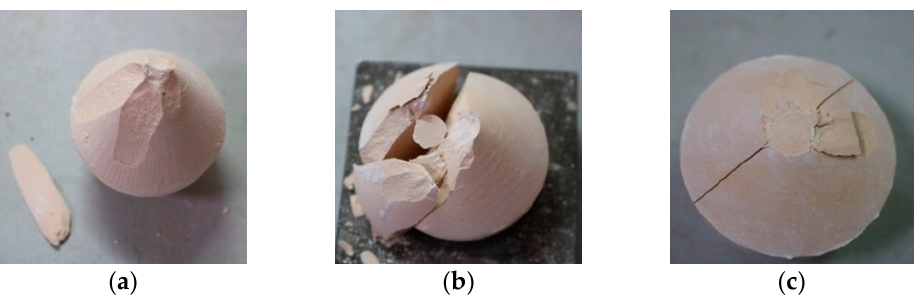
Figure 9. Breakage modes change with the increase in cone angle θ when the sphere diameter D is 50 mm and contact diameter is 7 mm: ( a ) θ = 60 ° ; ( b ) θ = 90 ° ; ( c ) θ =120 ° .